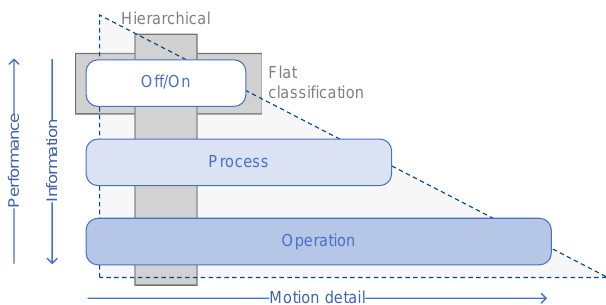
Figure 2. Classification problem for activity recognition modeling (white: LoD1; light blue: LoD2; and blue: LoD3) (adapted from [8,30]).